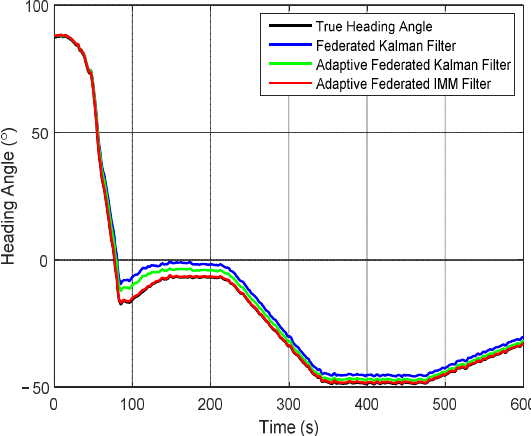
Sensors 2020 , 20 , x FOR PEER REVIEW Figure 7. The estimation curves of heading angle. Figure 7. The estimation curves of heading angle.